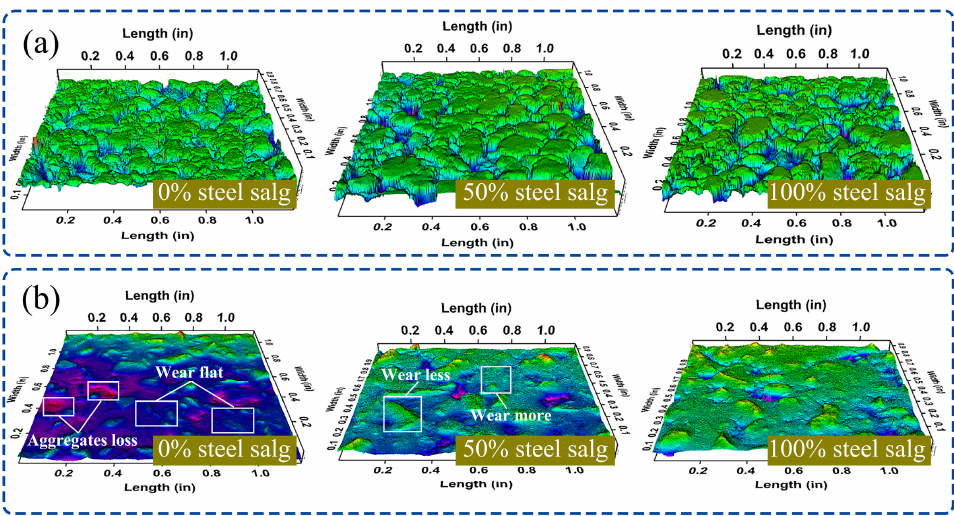
Figure 9. ( a , b ) are the surface texture of SSAM before and after 10 cycles of